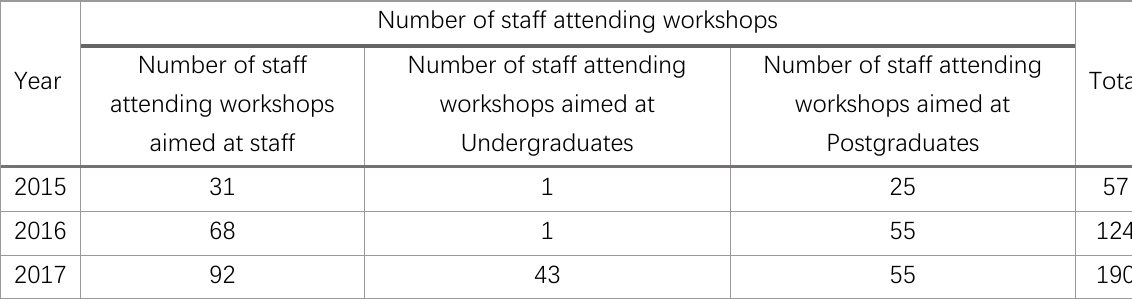
Table 2 : Breakdown of academic staff participation in workshops (2015 to 2017)